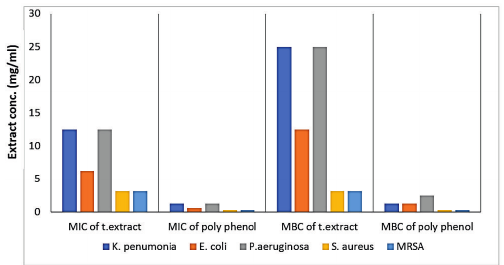
Fig. 5. MICs and MBCs of total extract and polyphenol fraction of Ziziphus spina-christi against tested MDR- bacterial